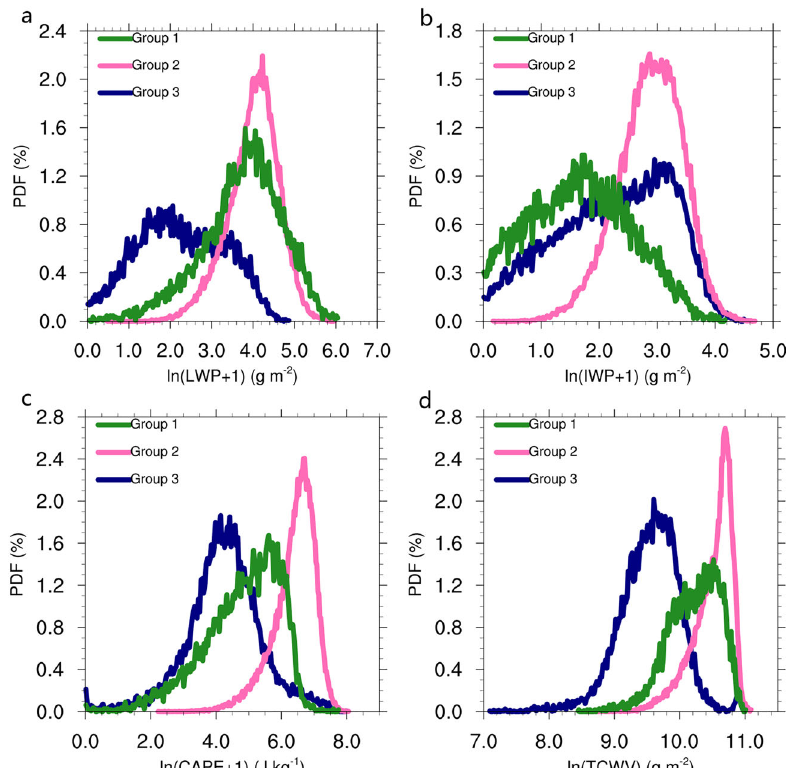
Fig. 3 Probability distribution functions (PDFs) of related variables in Group-1, 2, and 3. a Liquid water path (LWP), b ice water path (IWP), c convective available potential energy (CAPE), and d total column water vapor (TCWV). The abscissas are in logarithmic scale. LWP, IWP, and CAPE are processed with values >1 to avoid negative numbers when taking the logarithm. Group-1, 2, and 3 represent the thunderstorms with mostly liquid clouds, the thunderstorms with strong lightning density, and the thunderstorms with mostly ice clouds,